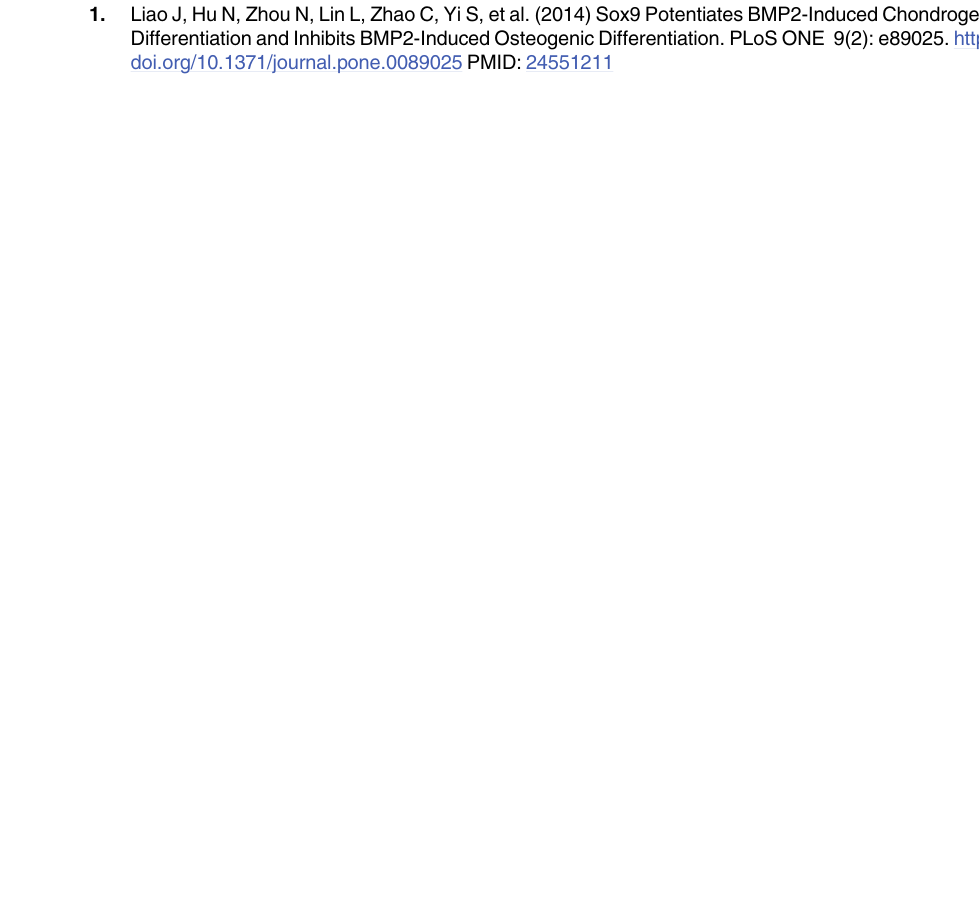
S6 File. Blots underlying Fig 5Bb. S7 File. Blots underlying Fig